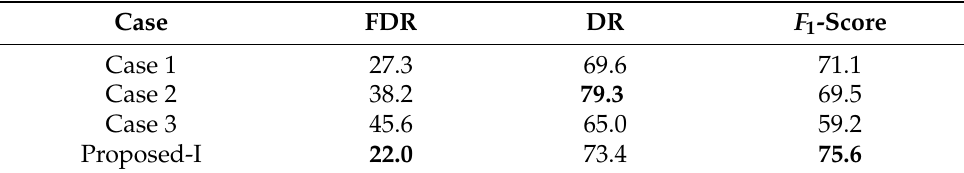
Table 3. The ablation experiment (%) on the testing set for the background-foreground classifier and tune-up boxes. CNN lw was used as the backbone network.